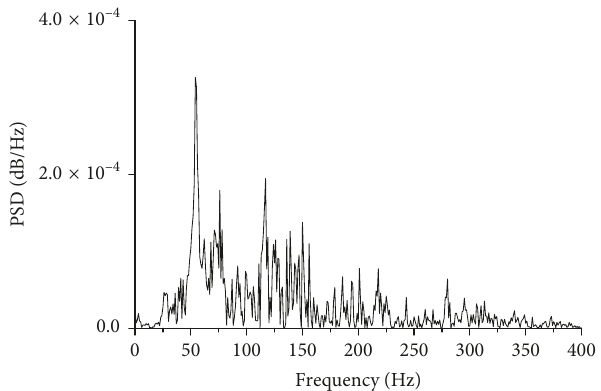
Figure 17: Vertical power spectral density after optimization.